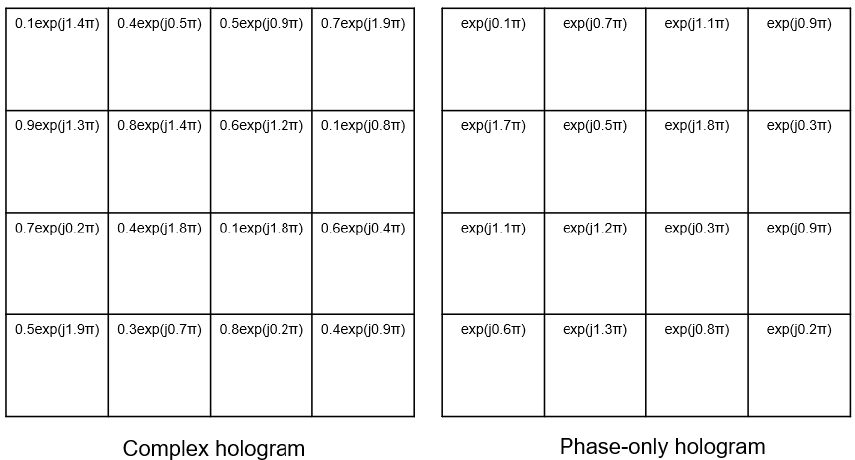
Figure 1. An example of complex hologram ( left ); and phase-only hologram ( right ) with a size of 4 × 4